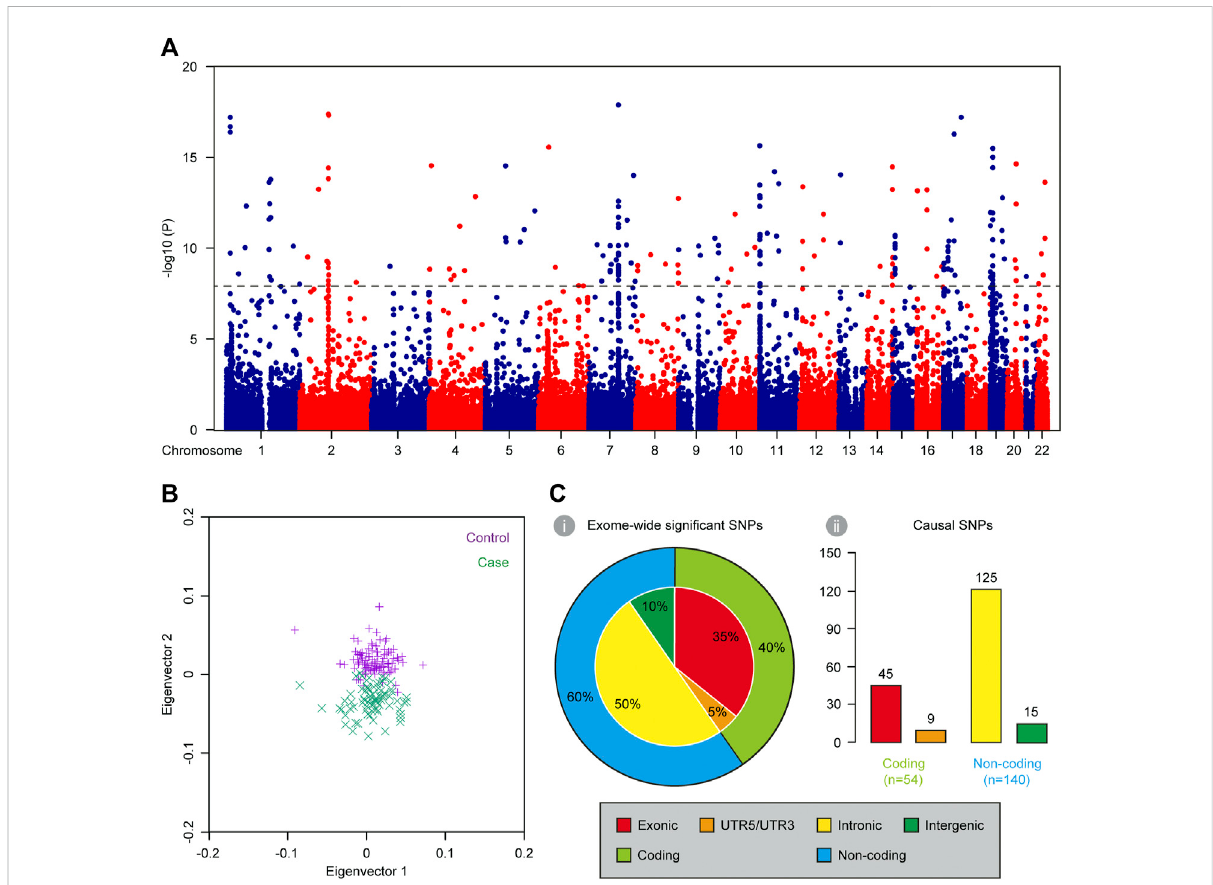
FIGURE 2 Characterization of causal SNPs for complex VSD via exome-wide association analysis. (A) Manhattan plot showing the base-pair position of each SNP along autosomal chromosomes on the x axis and − log 10 -transformed p values on the y axis ( n = 180). The black dashed line indicates the threshold for exome-widesigni fi cance ( p < 5×10 – 8 ). (B) PCA plotshowing the fi rsttwo eigenvectorsof80complexVSD casesand 100 controls. (C) Genomic distribution of exome-wide signi fi cant SNPs (i) and causal SNPs